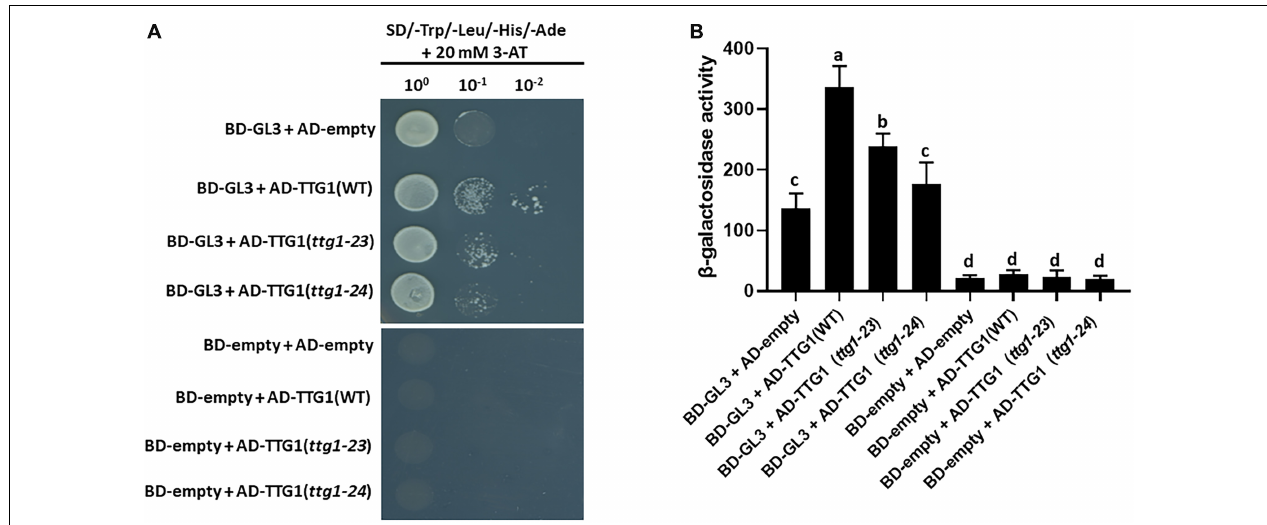
FIGURE 7 | Yeast two-hybrid protein interaction assays. (A) The growth of yeast cells harboring the GL3 fused to the GAL4 DNA-binding domain (BD-GL3) or the GAL4 DNA-binding domain alons (BD-empty), and TTG1(WT), TTG1( ttg1-23 ), or TTG1( ttg1-24 ) fused to the GAL4 activation domain (AD) are shown. The yeast cells are grown on the SD/-Trp/-Leu/-His/-Ade selection medium with 20 mM 3-aminotriazole (3-AT). For serial dilution analysis, yeast cells were collected and adjusted to OD 600 = 1.0, and diluted to 10 0 , 10 − 1 , and 10 − 2 . (B) Yeast two-hybrid β -galactosidase activity assay quantifying the interaction between GL3 and TTG1(WT), TTG1( ttg1-23 ) or TTG1( ttg1-24 ). Three independent biological replicates were performed for each combination. Error bars represent standard deviations from the three replicates. Bars marked with the same letter indicate values not significantly different; bars marked with different letters indicate values showing statistically significant differences ( P < 0.05; ANOVA test).